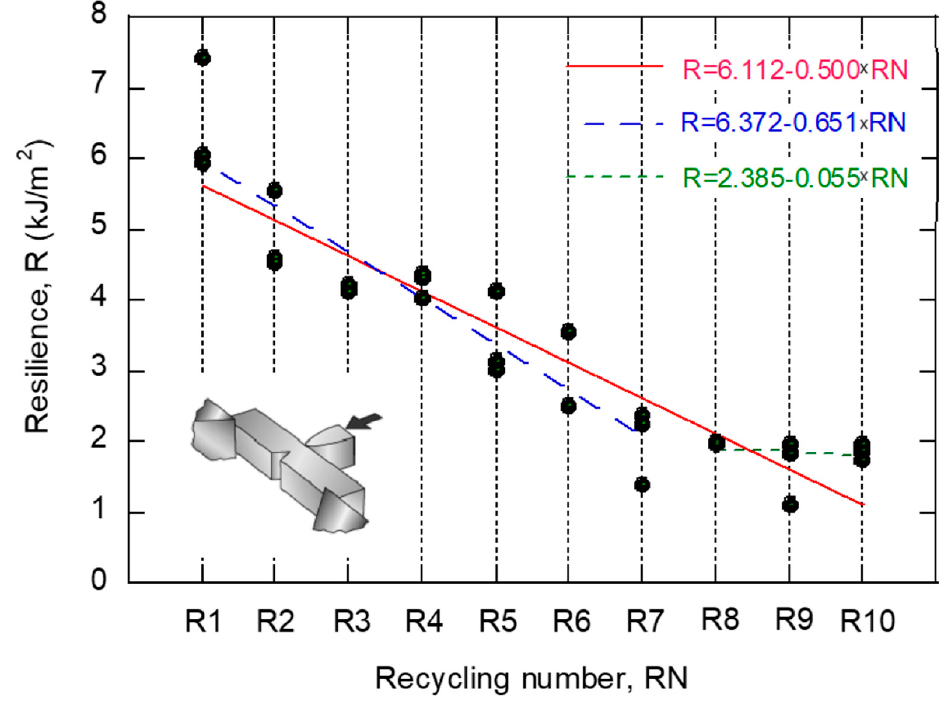
Figure 6. Evolution of impact strength with recycling number. Table 6. Summary of results obtained from the linear fitting (R = β 0 + β 1 ·RN) of the resilience. The coefficients β 0 and β 1 are accompanied with their 95% confidence bounds.